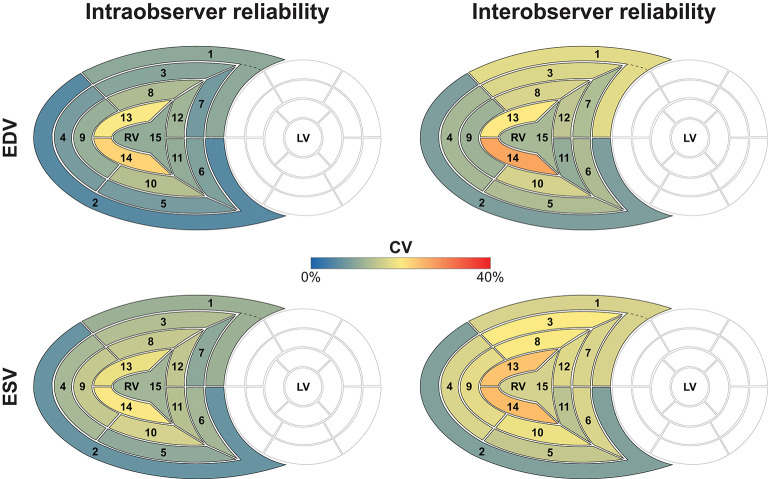
Intra- and interobserver reliability of right ventricular end-diastolic and end-systolic segmental volumes. The 15 segments are color-coded based on the value of the coefficient of variation: reddish colors indicate a higher, whereas blueish colors correspond to a lower value of coefficient of variation. Segment numbers as defined in Figure 3. EDV, end-diastolic volume; ESV, end-systolic volume; CV, coefficient of variation; LV, left ventricle; RV, right ventricle.